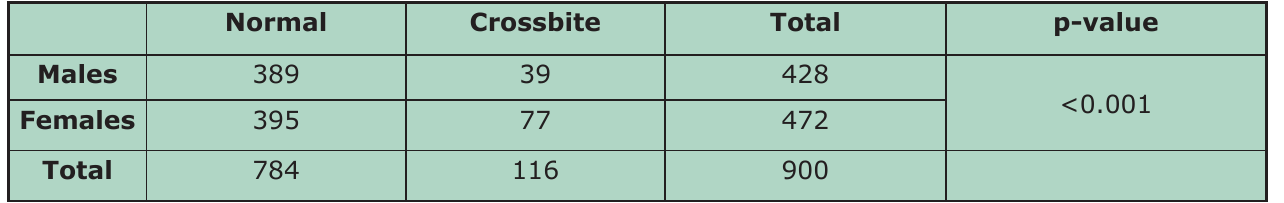
Table-II: Prevalence of crossbite in males and females.